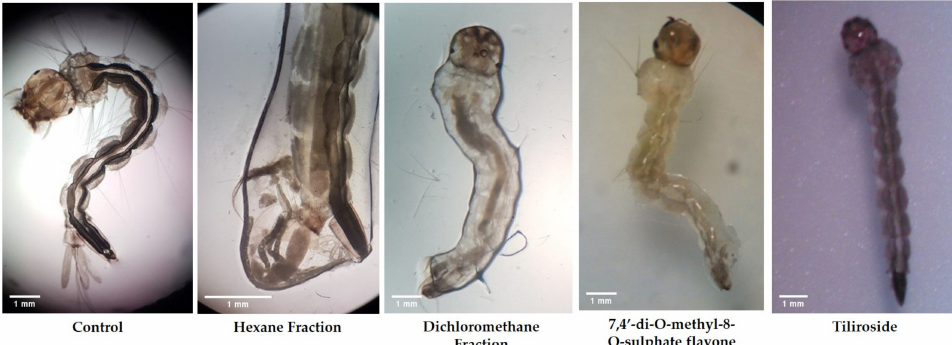
Figure 2. Stereomicroscopic view of fourth instar of A. aegypti larvae after 24 h of exposure. Substances induced toxic e ff ects on many regions of the body (including thorax, abdomen, anal gills, loss of external hairs, crumbled epithelial layer of the outer cuticle, and shrinkage of the